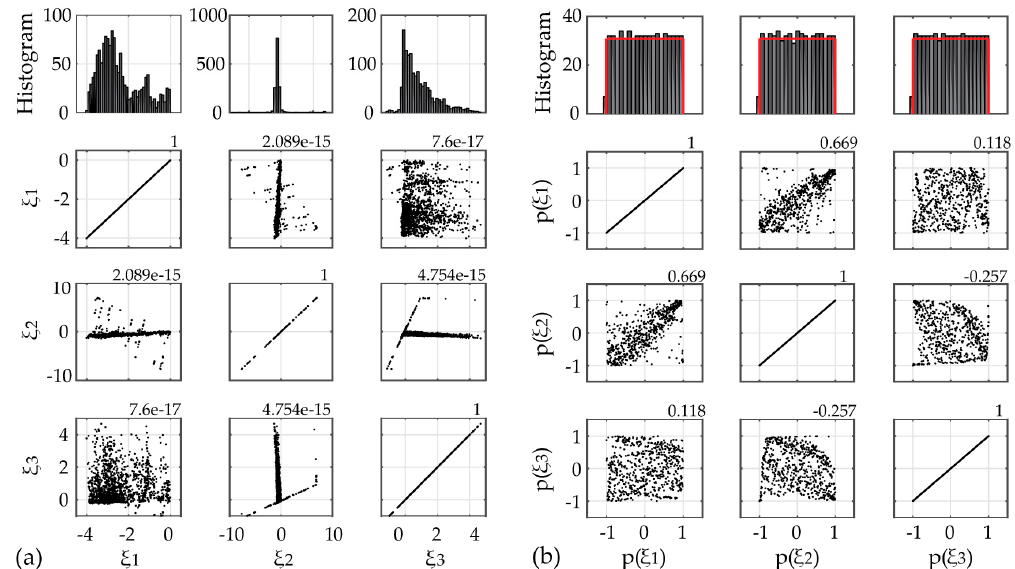
Figure 13. Input data for Case A: ( a ) Scatter plots of ICA-based input variables and estimated correlation values, histograms of the latent variables (upper row); ( b ) Scatter plots of the random vector Ξ of prescribed uniform PDF p Ξ ( ξ ) , histograms of the random vector Ξ values (upper row).